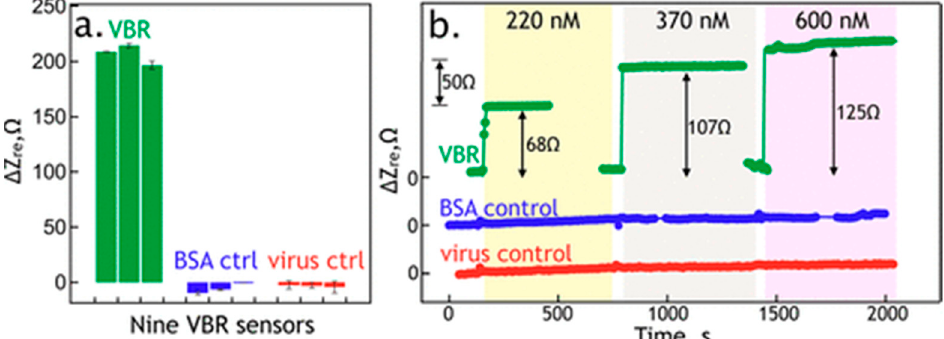
Figure 8. ( a ) Selectivity of the human serum albumin (HSA) virus bioresistor sensors against bovine serum albumin (BSA) (VBR sensor operated in a solution of BSA instead of HSA) and the control (PEDOT layer containing wild type phages do not bind HSA), ( b ) VBR sensor response (real impedance change) for varied HSA concentrations, control BSA probes and wild-type virus were applied as in ( a ). Reprinted with permission from [60]. Copyright 2018 American Chemical Society.